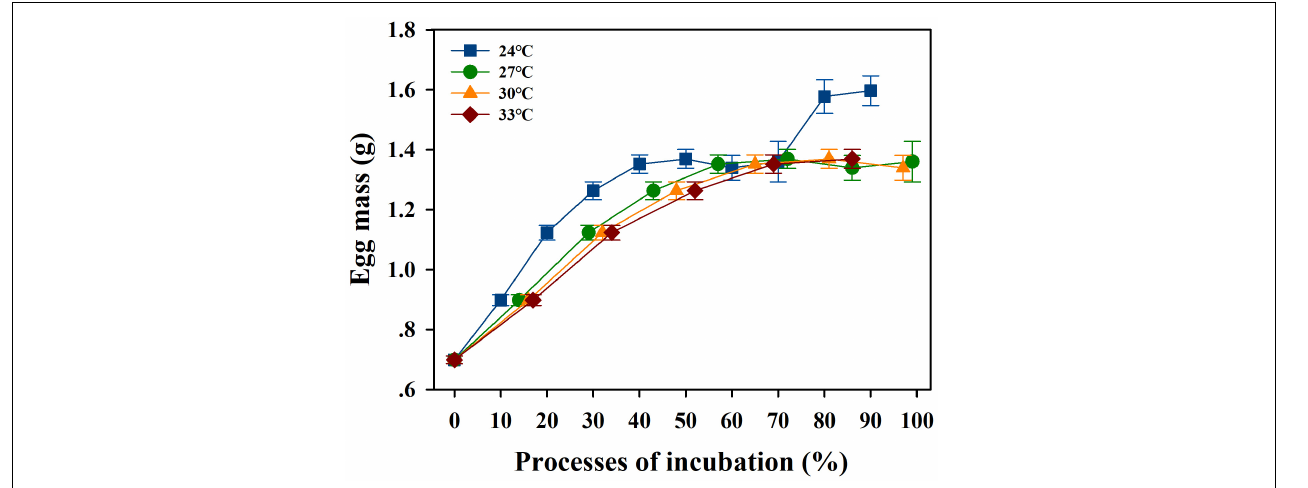
FIGURE 2 | Egg mass increase during incubation. The blue, green, orange and red spot and lines indicate the eggs incubated under 24, 27, 30, and 33 ◦ C, respectively. The data are shown as mean ± SE .